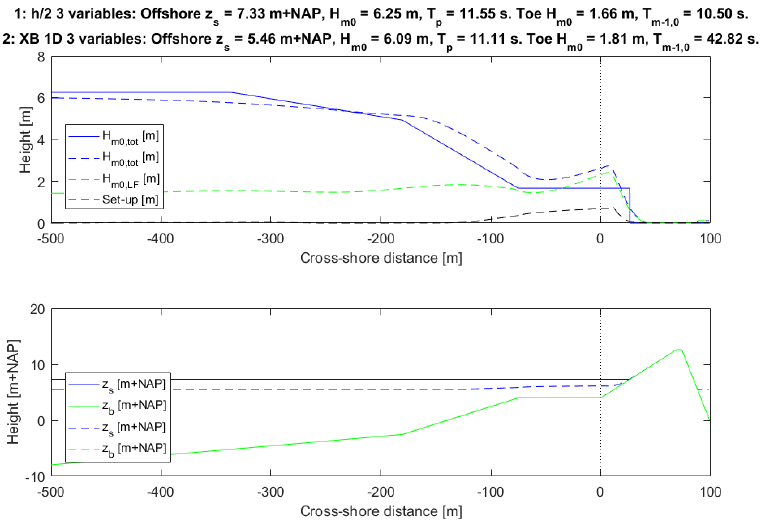
Figure 7. h /2-model (solid lines) versus XBeach 1D (dashed lines) with the offshore conditions as stochastic variables and a morphostatic foreshore at the design point. The dike toe is indicated by the dotted line.